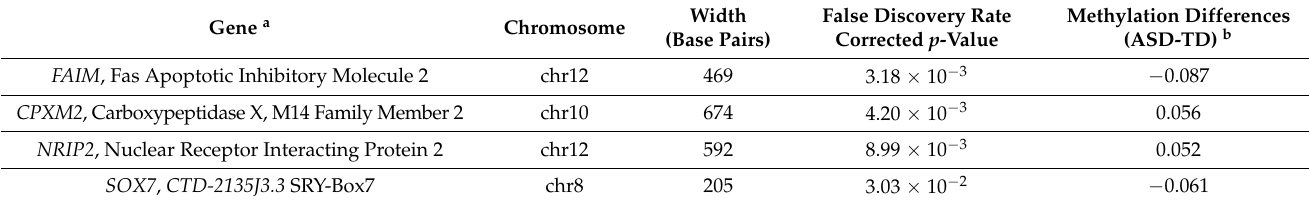
Table 2. Differentially methylated regions between individuals with ASD and TD